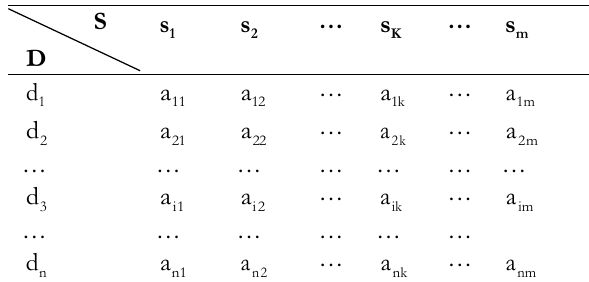
Table 1. Decision